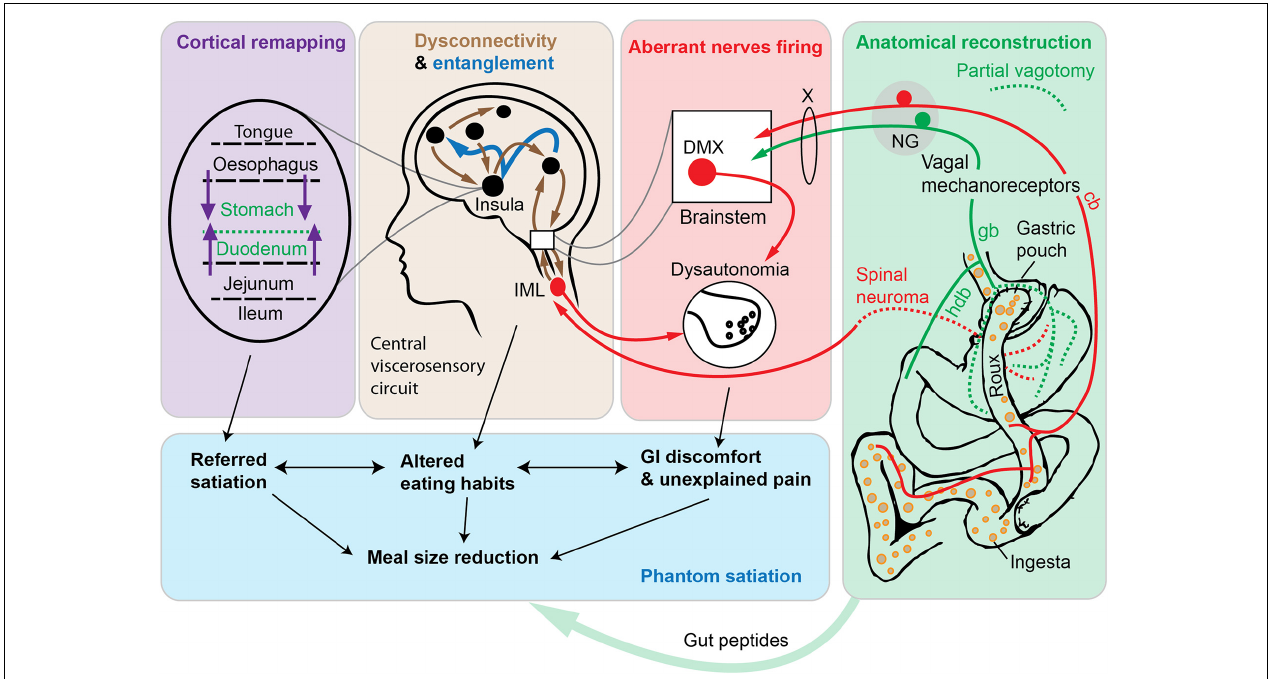
FIGURE 1 | Schematic diagram depicting the phantom satiation hypothesis. According to the observations presented in this article, the metabolic benefits of Roux-en-Y gastric bypass (RYGB) are mediated, at least in part, by a combination of aberrant changes in a complex viscerosensory neural circuit. A key event following RYGB surgery is an unintentional gastric denervation (green box). Available data indicate that RYGB is associated with a gastric denervation (green dotted lines indicate axotomized axons of vagal or spinal origins). The duodenum itself can be conceived as a functionally denervated, in the sense that duodenal afferents cease to be directly stimulated by nutrients and mechanical stimuli. According to our hypothesis, partial vagotomy leads to widespread maladaptive changes in peripheral nerves (red box and arrows) and in central viscerosensory circuits (brown box and arrows). In particular, in animal models of bariatric surgery, sympathetic, parasympathetic, and nociceptive nerves behave as if they were hyperresponsive to a meal (red arrows). At the central level, altered connectivity in many cortical and subcortical areas has been reported after RYGB using brain imaging technologies in human subjects. In addition, the entanglement of viscerosensory modalities (dark blue arrows) may further participate to abnormal emotional and sensory responses to eating. Finally, the remapping of insular cortices involved in gastrointestinal territories representation is likely to occur (purple box and arrows), thereby contributing to viscerosensory anomalies and referred sensations. This neurobiological model, directly inspired by the literature on phantom limbs, predicts that subjects with RYGB may experience exaggerated satiation. Ultimately, reduced meal size and perturbed eating patterns (blue box), among other postprandial anomalies, may contribute to weight loss. Hence, the “phantom satiation” hypothesis reinterprets bariatric surgery as a type of injury—that is to say a procedure that inflicts irreversible anatomical and functional damage—even if an injury with evident long-term health benefits. Abbreviations: cb, celiac branch; deaf., deafferentation; DMX, dorsal motor nucleus of the vagus; gb, gastric branch;